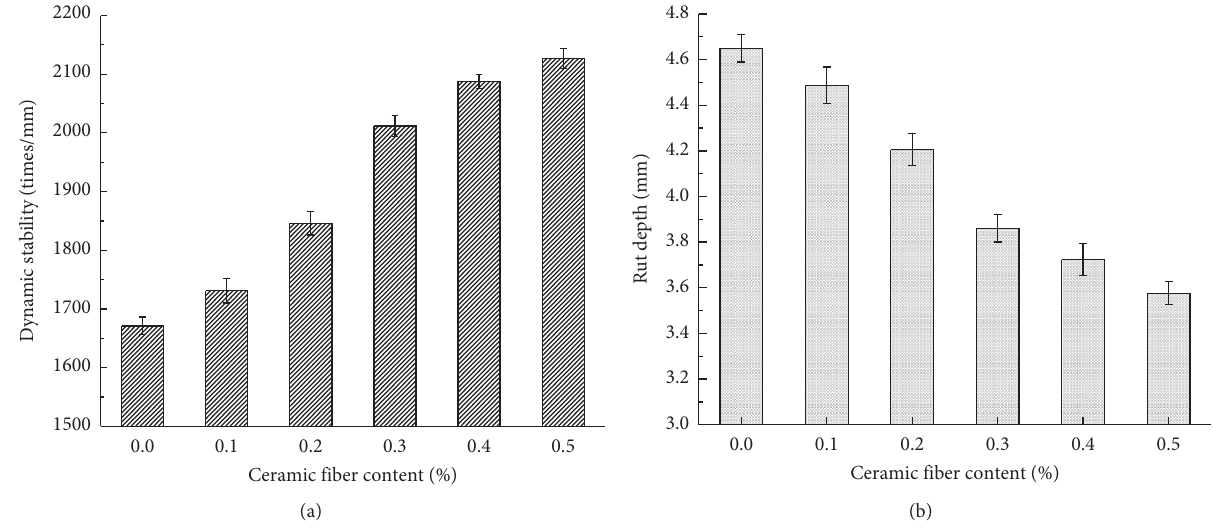
Figure 9: Results of wheel tracking test. (a) Dynamic stability. (b) Rut depth.